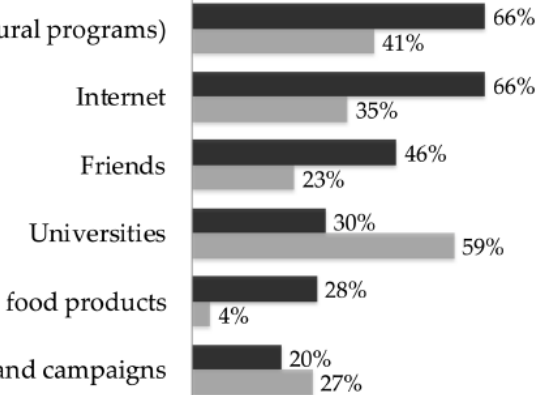
Figure 1. Sources of information on animal related issues (Sv1, n = 441). Black bars = most consulted sources, grey bars = trusted sources.